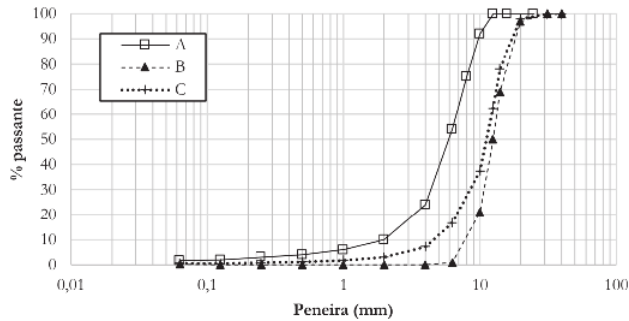
Na Figura 2 e na Tabela 1 são apresentadas as curvas granu- lométricas e a análise granulométrica dos agregados de escória